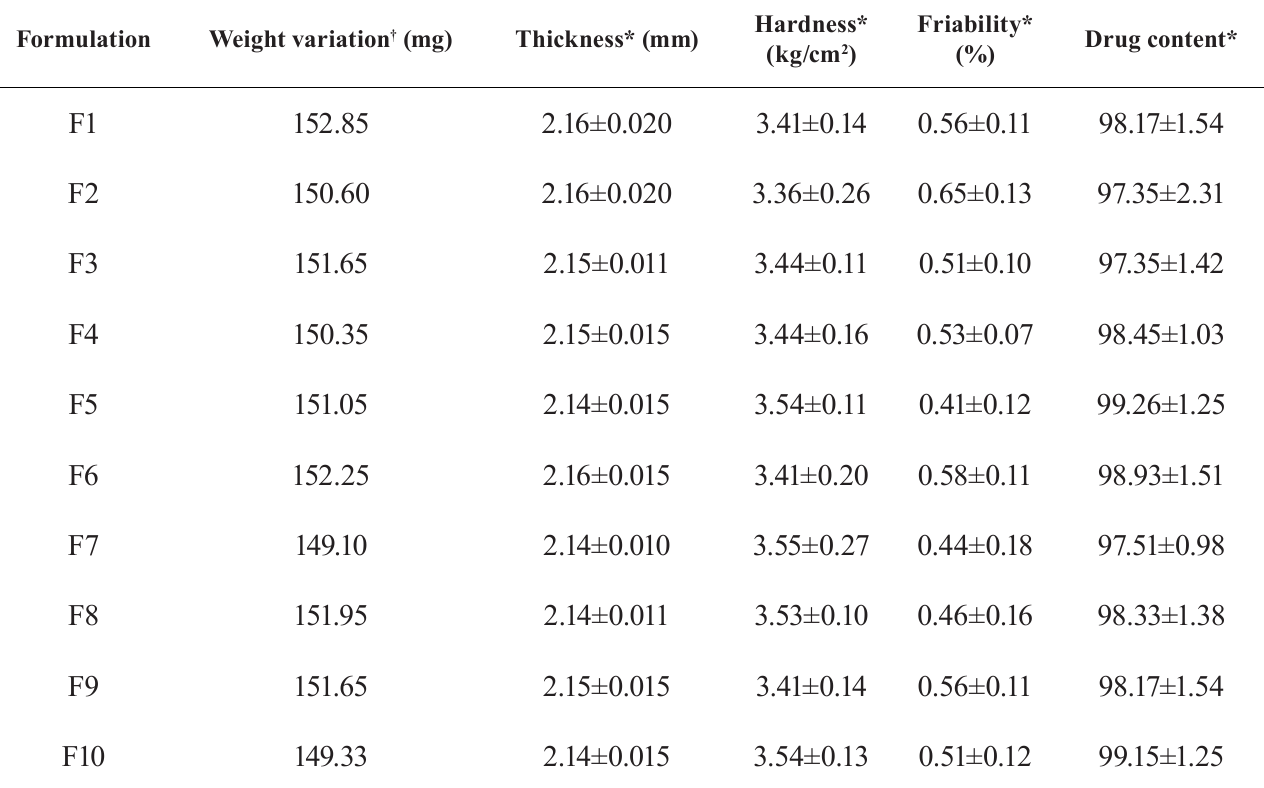
TABLE III - The physical evaluation of muco-adhesive buccal tablets